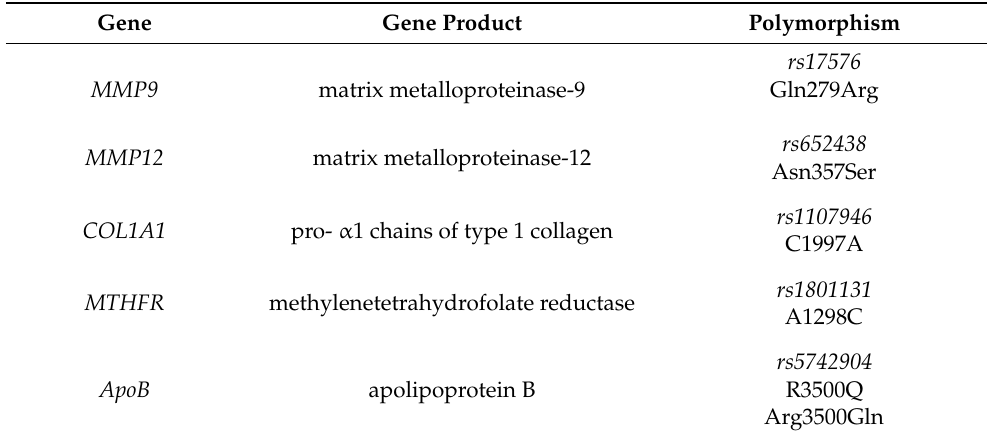
Table 1. The studied genes, their products and polymorphisms. Gene Gene Product